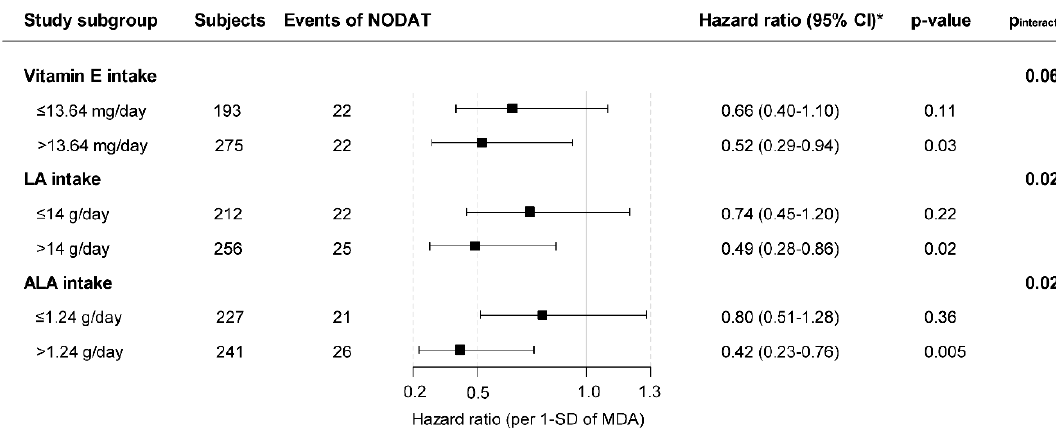
Figure 2. Stratified analysis of the association of plasma MDA concentrations with NODAT. * For the association between MDA and NODAT. HR are reported per 1-SD increase in plasma MDA concentration. Nutrient intake was adjusted for total energy intake according to the residual method.